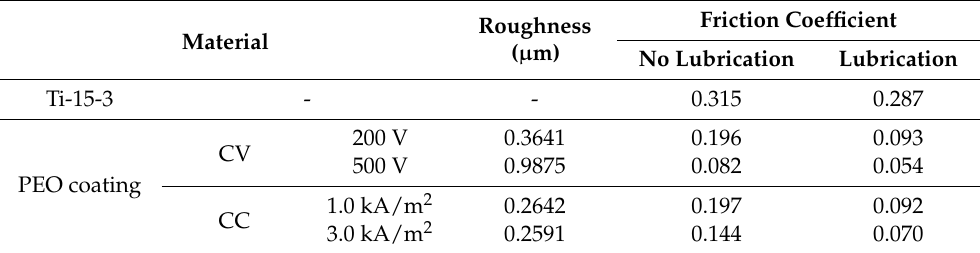
Table 5. Surface roughness and friction coefficient of Ti-15-3 and the PEO